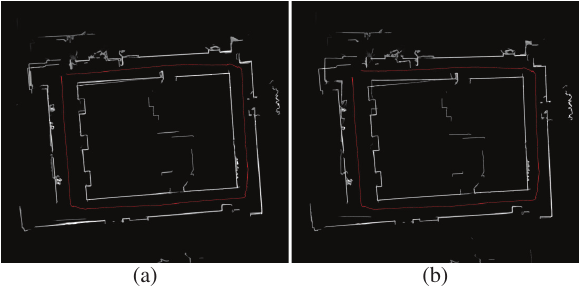
Figure 6: The occupancy likelihood maps of a narrow and closed-loop indoor office corridor with a length of about 100 m associated with the moving trajectories (marked in red lines) of the UGV generated by considering the scan distortion compensation in (a) and without it in (b).